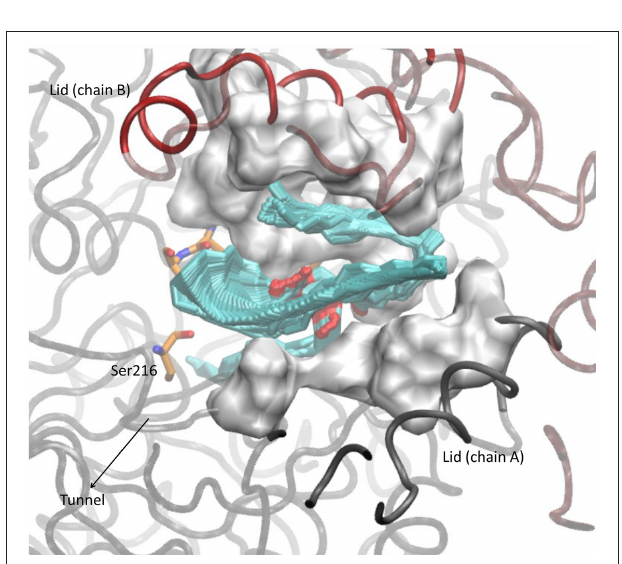
FIGURE 3 | Conformation adopted after 15 ns molecular dynamic simulation in the WT OPE docked with a molecule of tripalmitin.